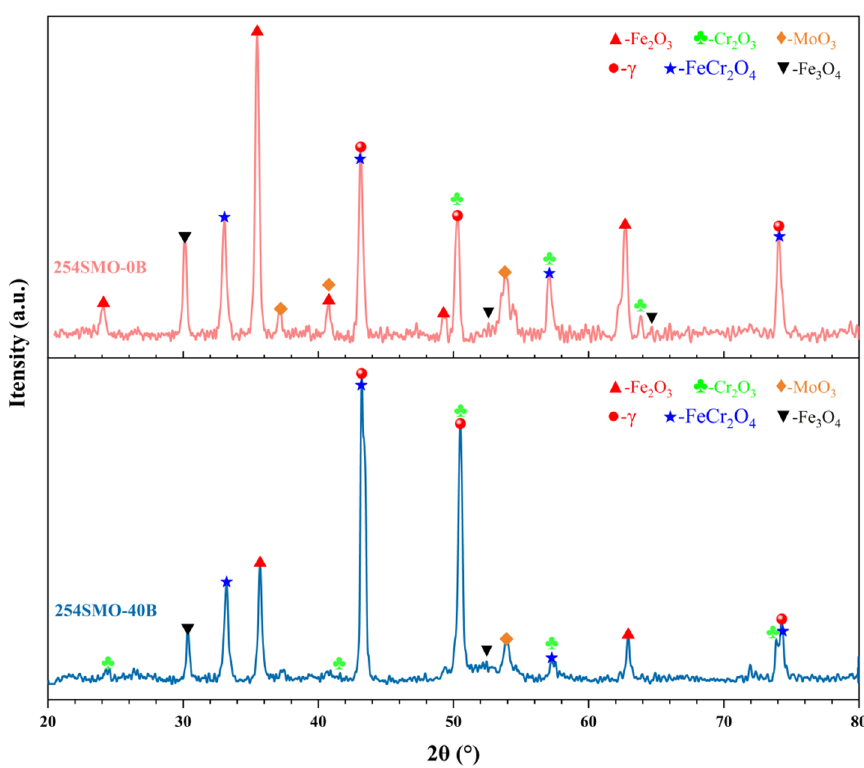
Figure 6. The XRD patterns of the 254SMO–0B and 254SMO–40B samples after oxidation at 900 ◦ C Figure 6 . The XRD patterns of the 254SMO – 0B and 254SMO – 40B samples after oxidation at 900 °C for 30 for 30min.